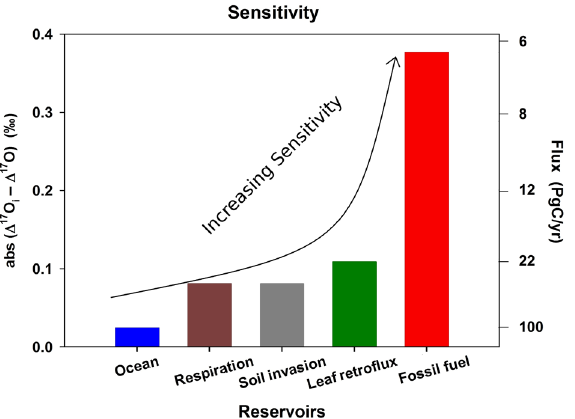
Figure 3. Sensitivity of the processes considered (in terms Δ 17 O i ; see text and Table 1 for the respective values) as affecting the Δ 17 O budget of CO 2 in the atmosphere. The corresponding gross fluxes needed are shown on the right-axis; the values are normalized to oceanic flux at 100 PgC/year. The higher the abs (Δ 17 O i − Δ 17 O)